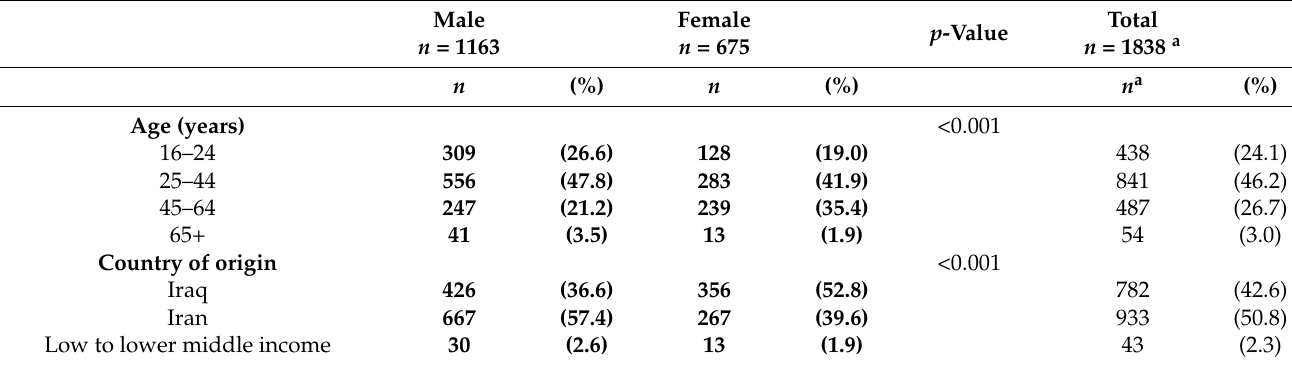
Table 1. Demographics of Arbaeen 2019 survey participants for whom data were